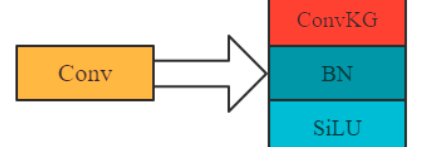
Figure 6. Improved convolution module.